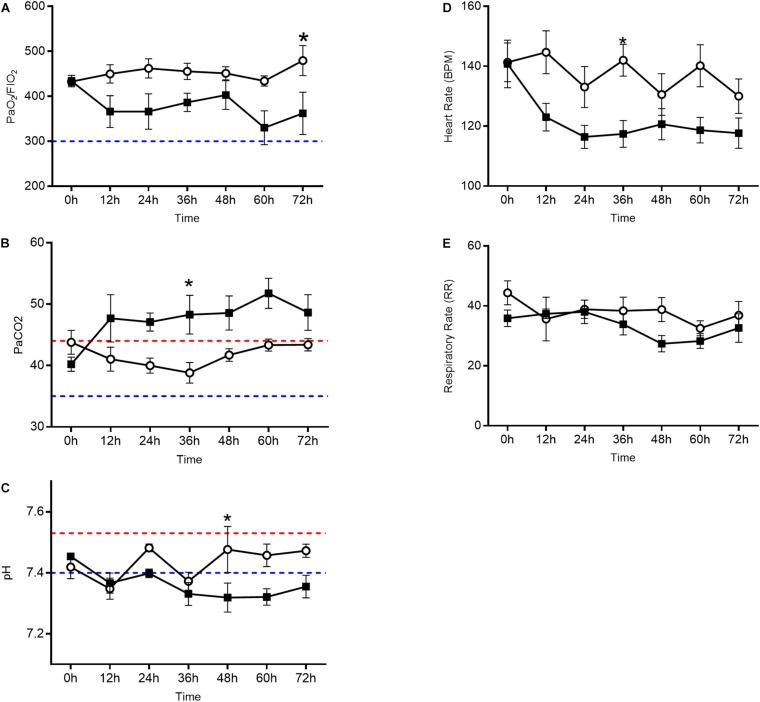
Arterial blood gas analysis and vital sign assessment in the oxygen group (closed squares) compared to the air control group (open circles). Line graphs depict PaO2/FiO2 ratio (A), PaCO2
(B), and pH (C) in addition to heart rate (D) and respiratory rate (E). The oxygen group had a decreased PaO2/FiO2 ratio, elevated PaCO2, and decreased pH (p < 0.0001 repeated measures ANOVA) when compared to the air control group. Each data point represents mean ± SEM. Swine reference ranges for upper (red) or lower (blue) range of normal values are indicated by the dashed lines in (B) through (C). For (A), blue dashed line represents threshold for ARDS (Bernard et al., 1994).